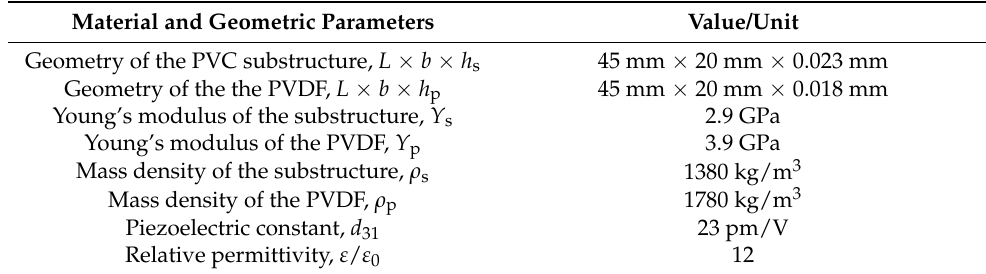
Table 1. Geometric dimensions, material properties, and electromechanical parameters of the flexible doubly clamped energy harvester.